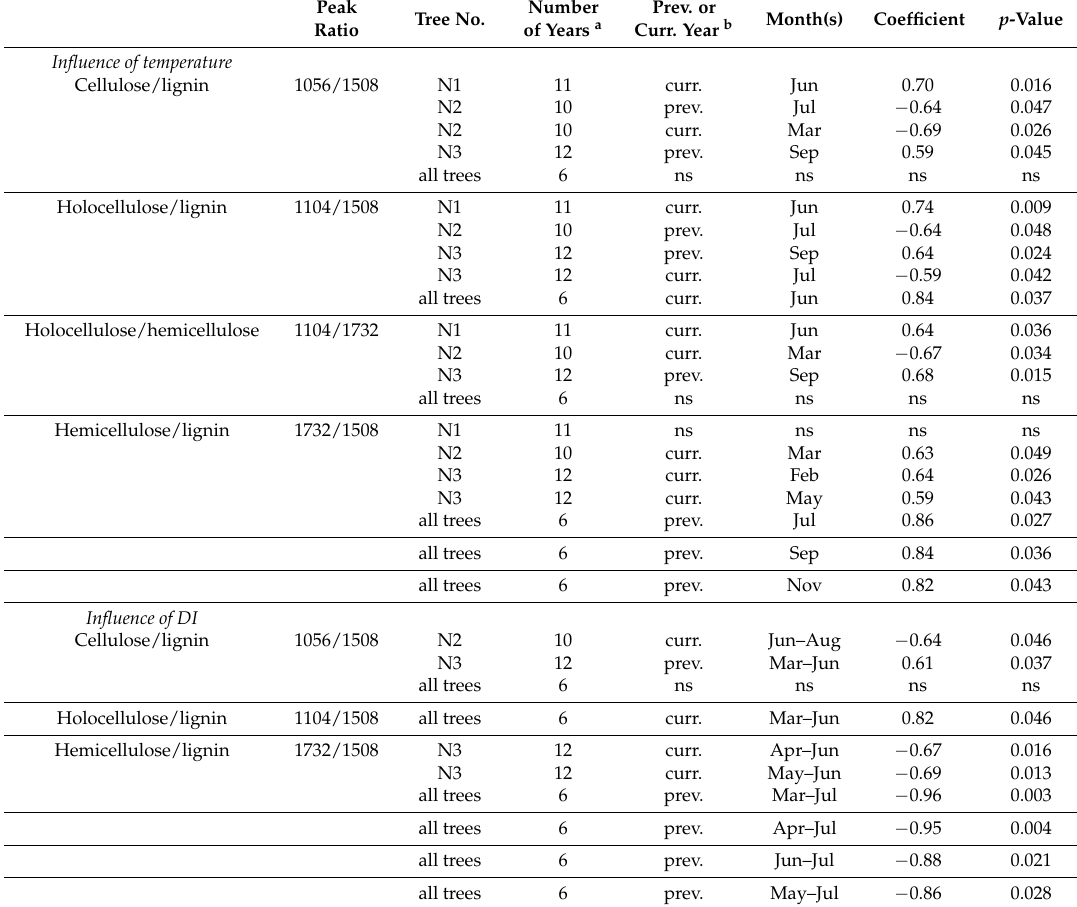
Peak Number Prev. or Month(s) Coefficient p -Value Tree No. of Years a Curr. Year b Ratio